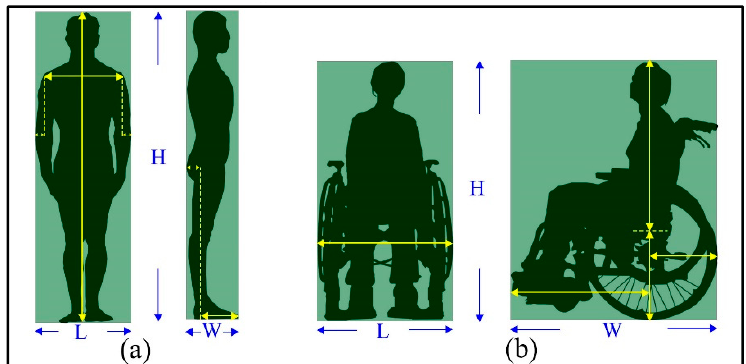
Figure 2. The object spaces (O-Spaces) of ( a ) a non-disabled adult and ( b ) a disabled adult.